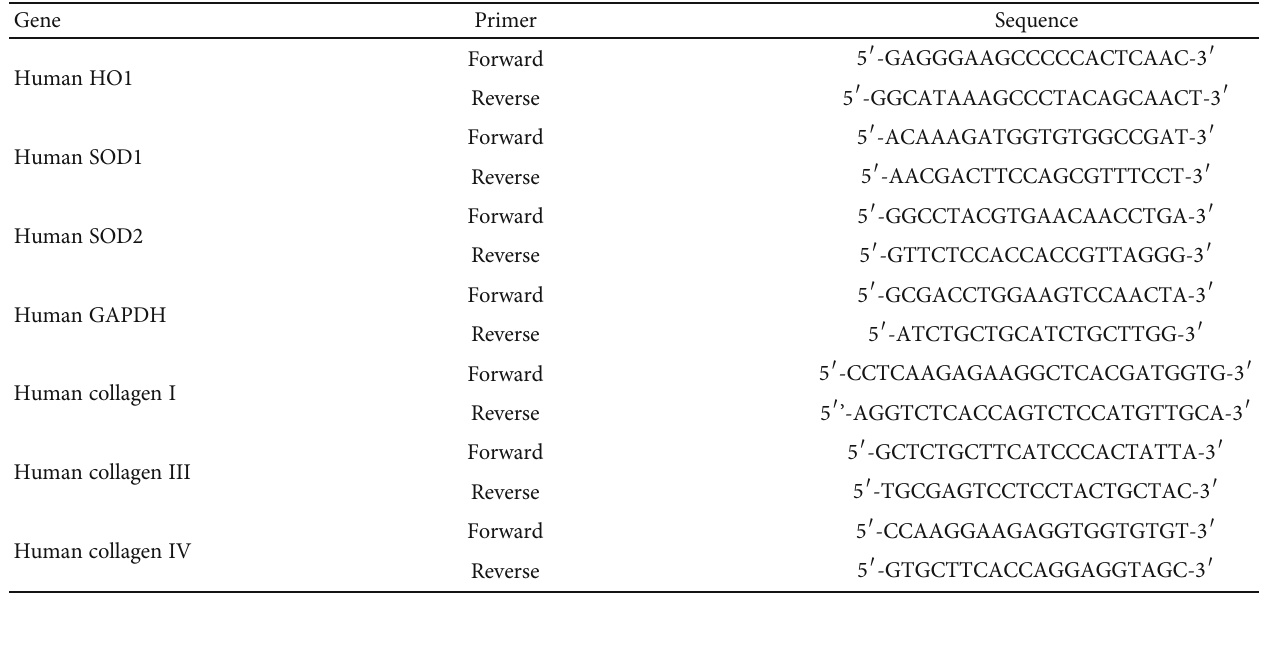
Table 1: Primer sequences.